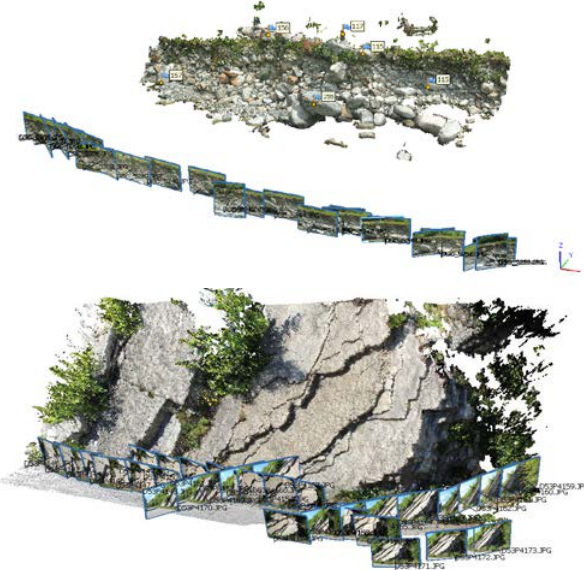
Figure 1. Two typical configurations of terrestrial photogrammetric networks in Cat. 1. In the upper part (a), a block configuration including a main strip, a few 90° rolled photos, and convergent photos. In the lower part (b), the block consists of a main strip and two other diagonal strips to fill